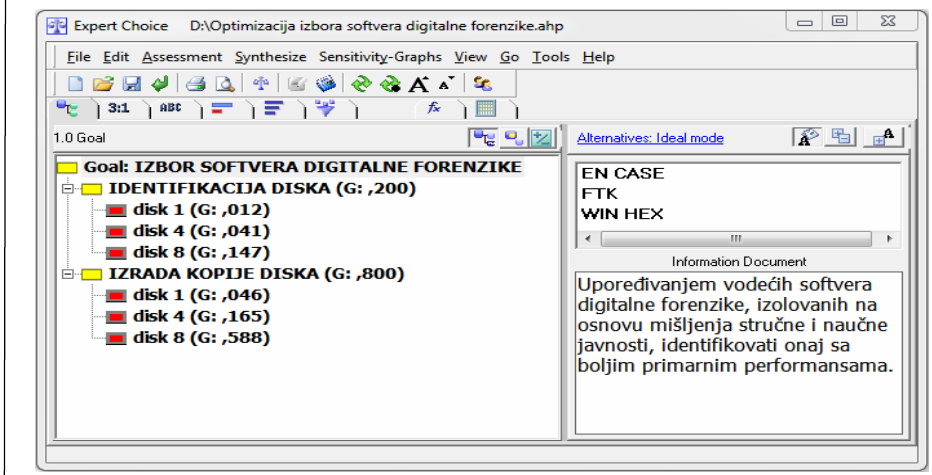
Figure 4 – Weights of criteria (sub-criteria) compared to the objective (criterion) Рис . 4 – Вес коэффициента критериев ( субкритериев ) к объекту ( критерий